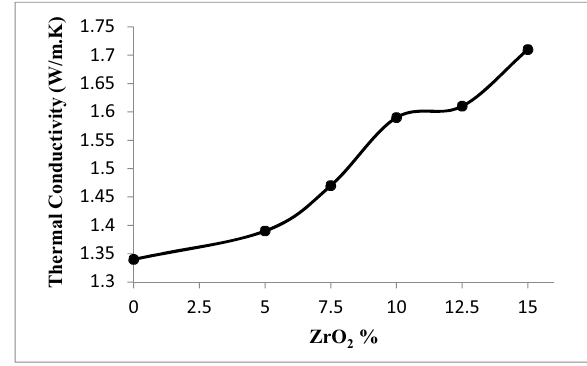
Figure 8: Compressive strength after thermal shock for various ZrO 2 additions in refractory specimens.